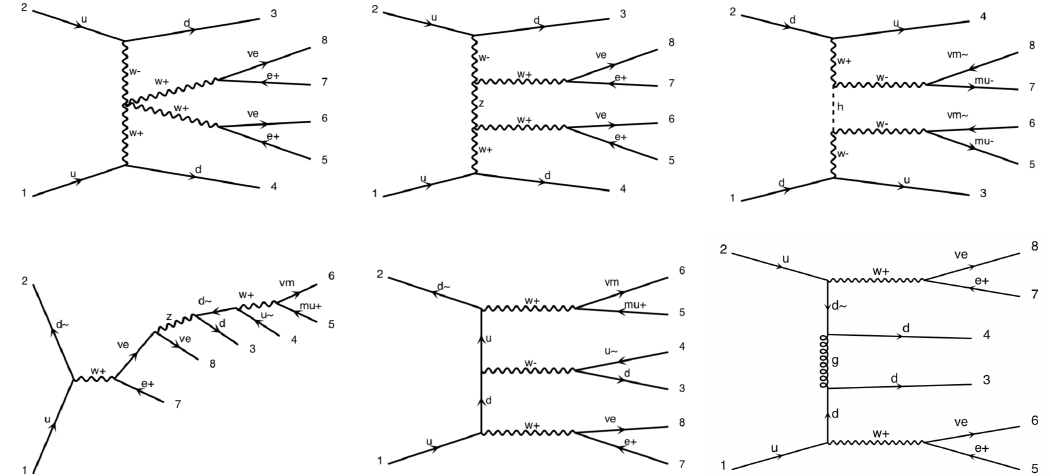
Figure 1: Representative leading order Feynman diagrams for pp → j j (cid:96) ± ν(cid:96) ± ν . Top row: Diagrams contributing to the signal, pp → j jW ± W ± → j j (cid:96) ± ν(cid:96) ± ν with σ ∝ α 6 . Bottom row: Diagrams considered irreducible background in this work. The dia- grams are drawn with MadGraph5 [ 47 ]